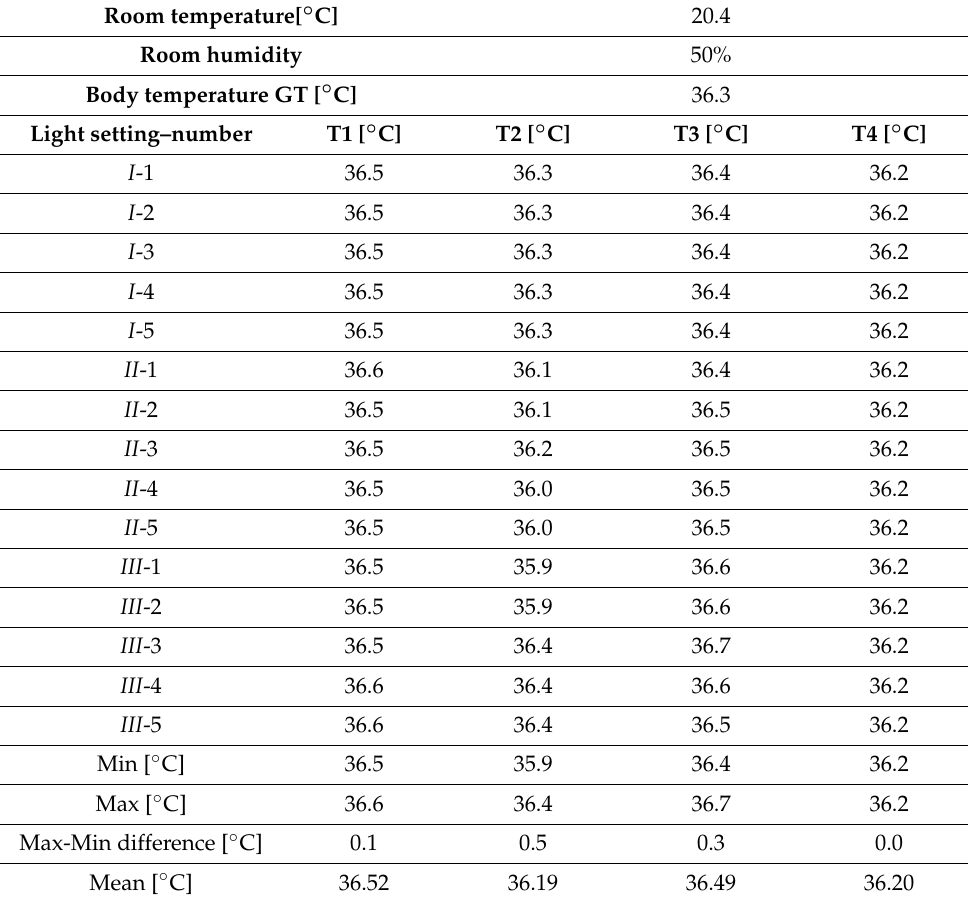
Table A10. Light influence experiment. Subject 1 body temperature data.